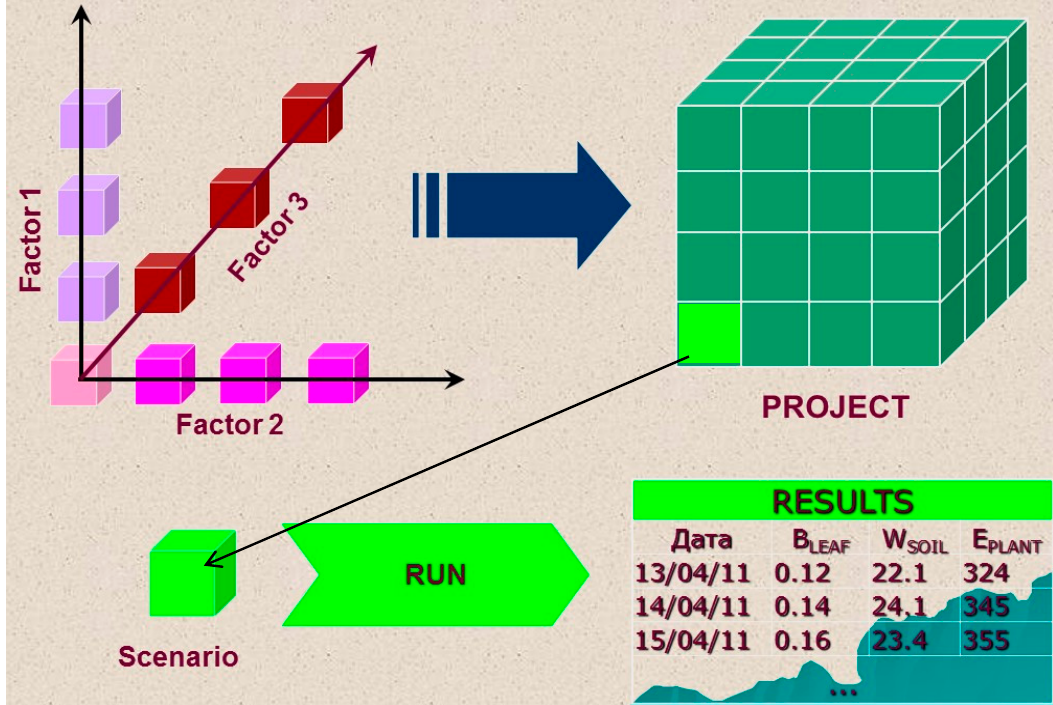
Figure 2. Multivariate running in Automation of Polivariant Experiments (APEX): full factor experiment for the case of the three factors.